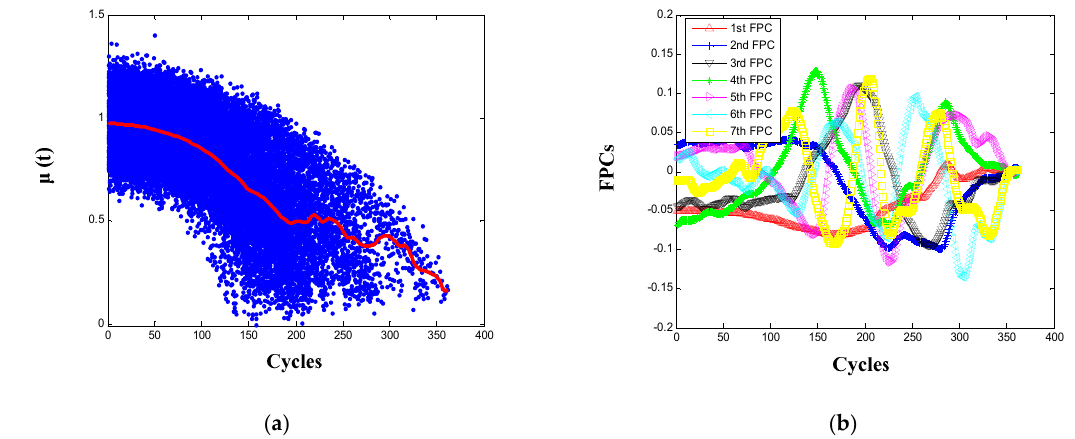
Figure 6. Estimation results: ( a ) the mean function; ( b ) the first seven functional principal components (FPCs).